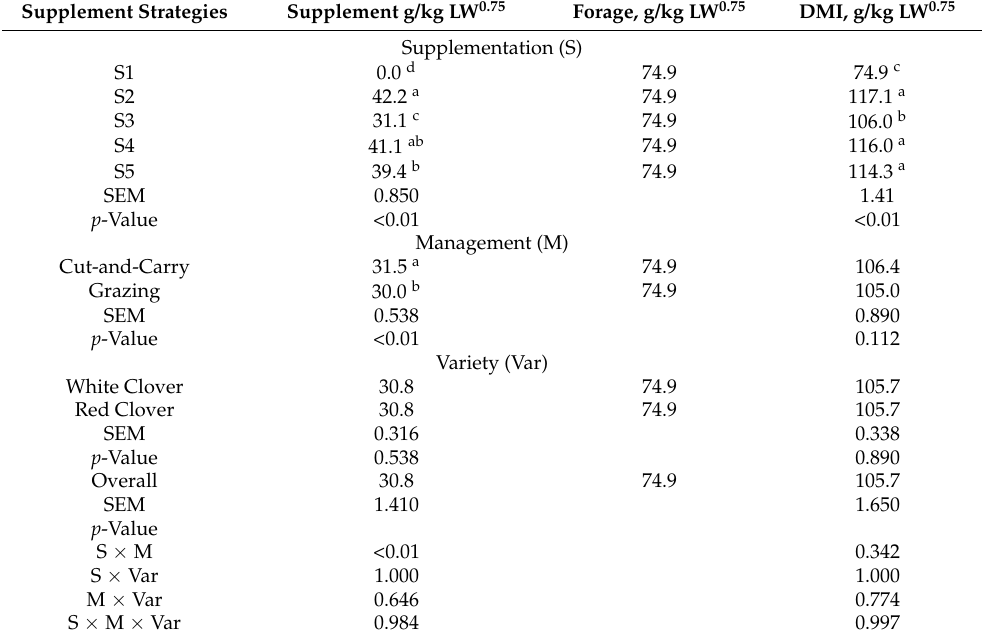
Table 4. Estimation of supplement and forage intake in live metabolic weight (g/kg LW 0.75 cow/day) using different strategies, five different supplementations (S) in dairy cattle under two feeding systems (grazing vs. cut-and-carry) with two leguminous forages (red clover or white clover). Supplement